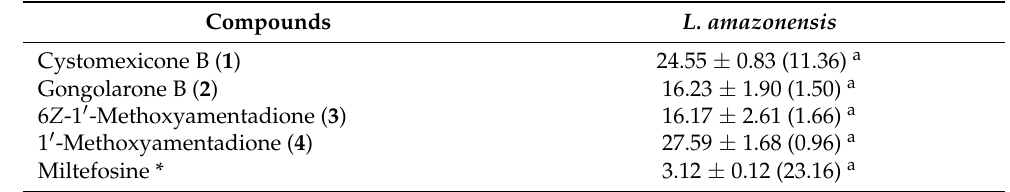
Table 2. Activity against amastigotes of L. amazonensis (IC 50 , µ M) of compounds 1 – 4 . a Selectivity index (CC 50 /IC 50 ); * reference drugs; ± represents the standard deviation.